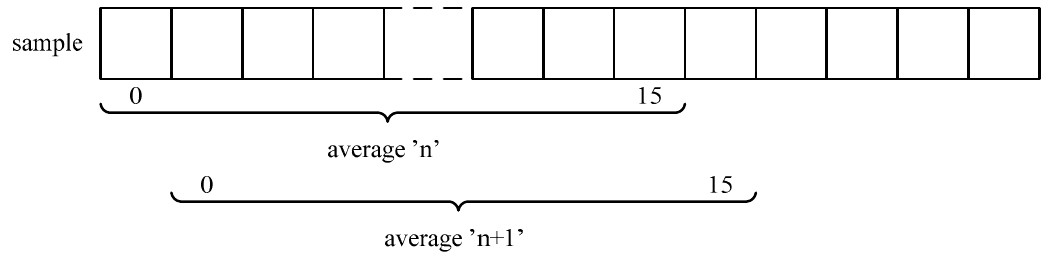
Figure 12. Method for determining the average of 16 samples.